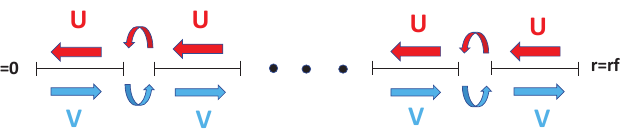
Figure 4. Sketch of the application of the boundary conditions between the different subdomain